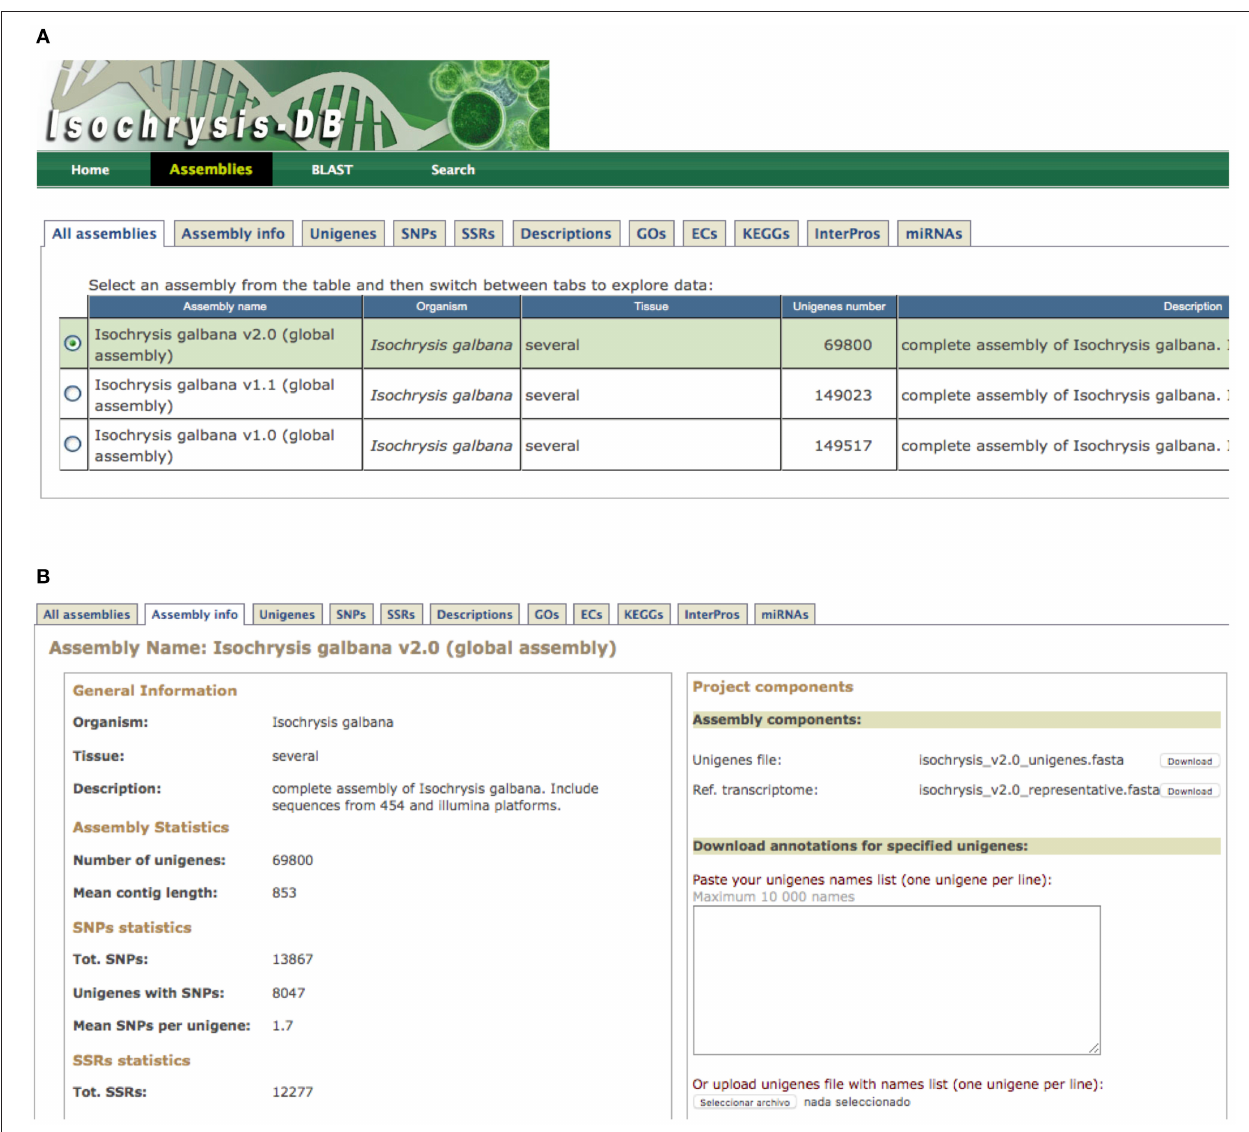
FIGURE 1 | IsochrysisDB interface. (A) “Assemblies” tab containing all information about transcriptomes; (B) Navigation window for T. luteav2.0 that includes the different tabs (“Assembly info,” “Unigenes,” “SNPs,” “SSRs,” “Descriptions,” “GO,” “ECs,” “KEGGs,” “InterPros,” and “miRNAs”) is shown. Moreover, the fasta files for full and reference transcripomes are available in the assembly components